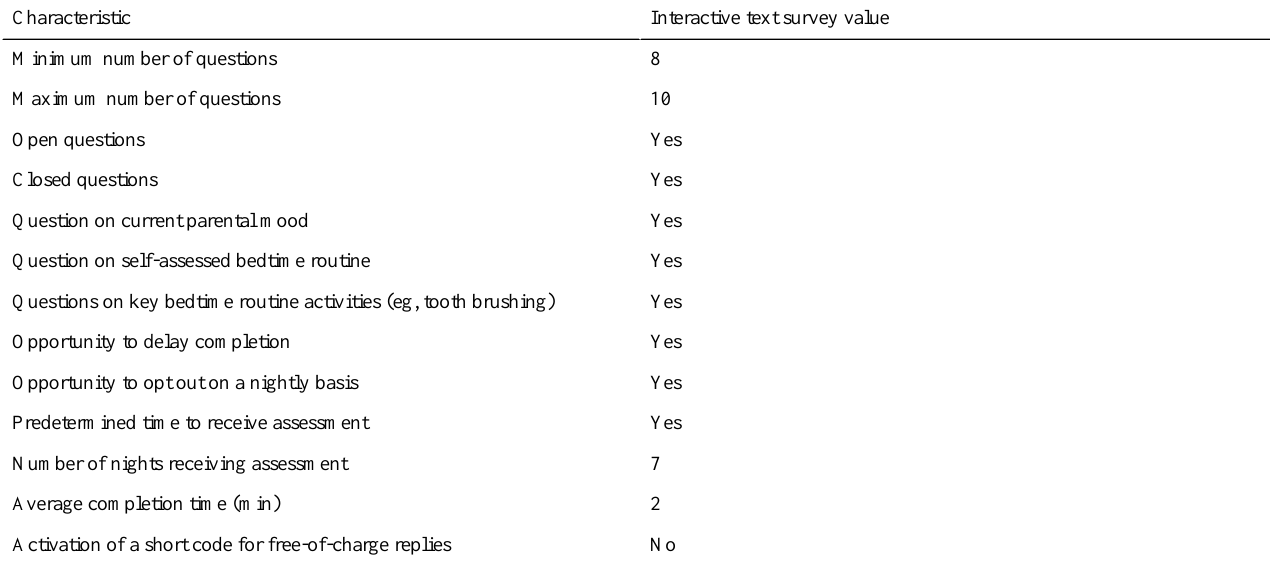
Table 1. Characteristics of the interactive text survey developed following public and patient involvement work.